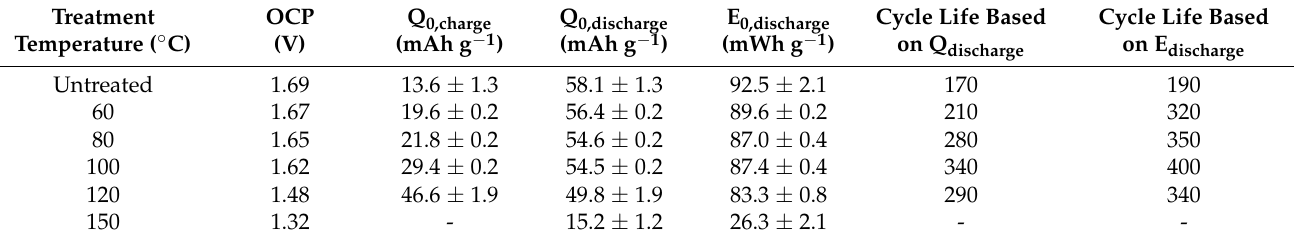
Table 1. Open-circuit potential, average amount of charge exchanged at full state of charge in the first cycle, average initial discharge capacity, average initial discharge energy, and average cycle life based on discharge capacity and discharge energy of all the synthesized CuHCF-based electrodes. The errors in OCP measurements are within ± 5 mV. All the values reported within this table were averaged by comparing at least two different samples resulting from two different thermally treated CuHCF